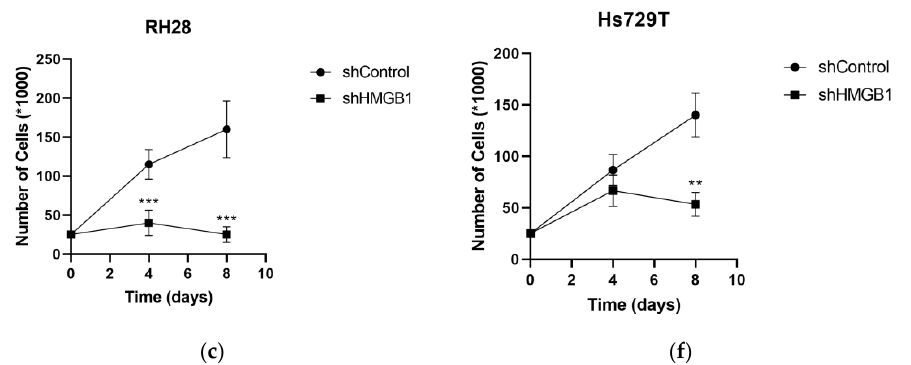
Figure 5. Proliferation of RMS cell lines after HMGB1 knockdown. The number of cells for the RH30 ( a ), RH41 ( b ), RH28 ( c ), RD ( d ), A204 ( e ) and Hs729T ( f ) cell lines was counted after 4 and 8 days of transduction with shHMGB1 lentivirus and compared against transduction with shControl lentivirus. ** p < 0.01, *** p < 0.001, Student t test. The data from one experiment are shown counting cells for quadruplicate in each point. RH30, RH41 and RH28: alveolar rhabdomyosarcoma cell lines. RD, A204 and Hs729T: embryonal rhabdomyosarcoma cell lines. RH30 cell lines with stable downregulation of HMGB1 (RH30 shHMGB1) after transduction with shHMGB1 lentivirus were selected by puromycin treatment for 2 weeks as well as for transduction with shControl lentivirus (RH30 shControl). RH30 shHMGB1 cell lines were treated with cisplatin at 5, 10 and 20 µM over 48 h, showing additional sensitivity to a cisplatin dose of 20% versus RH30 shControl with the different cisplatin doses (Figure 6).